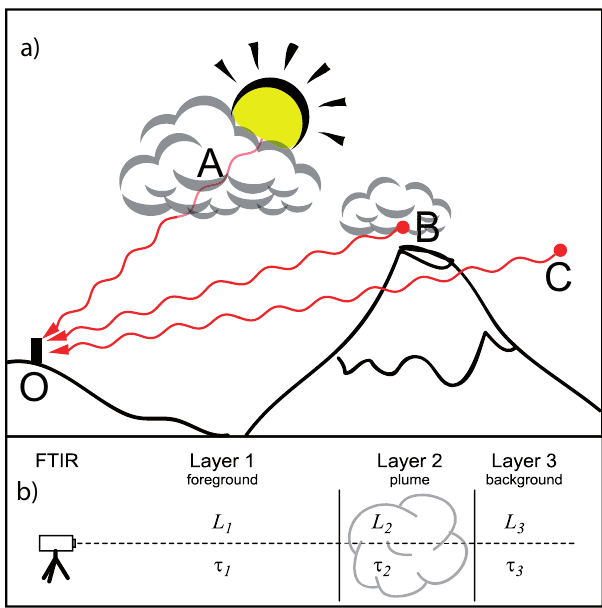
Fig. 1. (a) Different measurement geometries in the infrared using (A) solar/lunar absorption spectroscopy, (B, C) thermal emission spectroscopy at and beside the plume, respectively. SO 2 from Popocat´epetl can readily be detected from thermal IR spectra and imaged by performing 2-D scans around the crater. A plume-sky difference (C–B) was used to analyze the weak SiF 4 signal and cope with the strong interferences. (b) Sketch of the three layers (background, plume and foreground) used in the forward model to simulate the spectra.